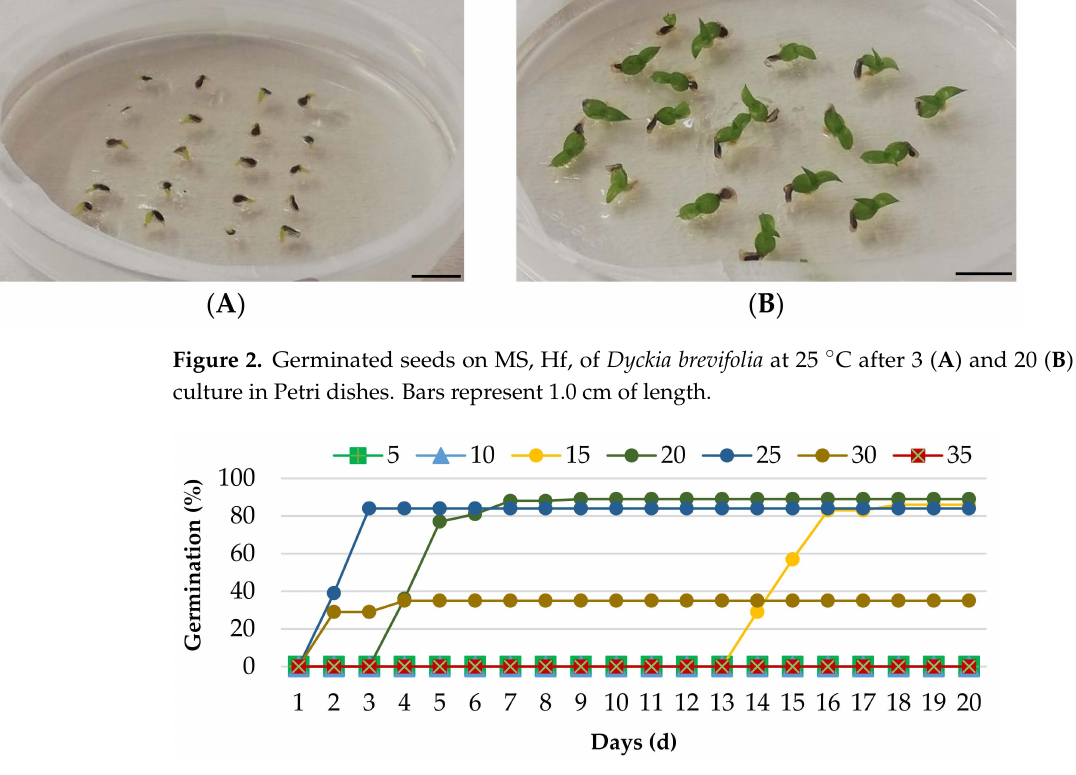
Figure 3. Germination time course curves of Dyckia brevifolia seeds as affected by temperature. Five replicates of 20 seeds per treatment were